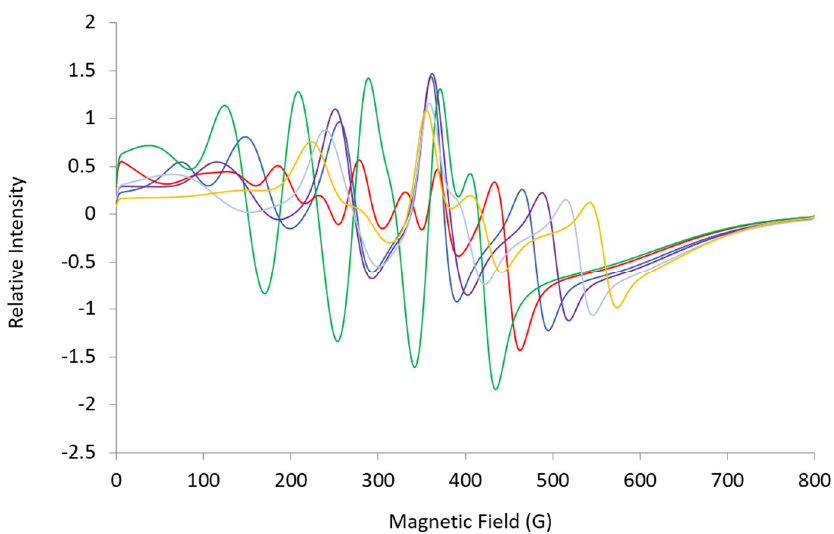
Figure 7. Simulated L-band (1.37 GHz) spectra: A = [369, 508, 100], g = [4.96, 4.55, 1.94], HStrain = [150, 150, 600] (blue); A -mid = 450 MHz (red), 400 MHz (green), 550 MHz (purple), 600 MHz (light blue), 650 MHz (yellow). Changes imply that L-band simulations are sensitive to A -mid.